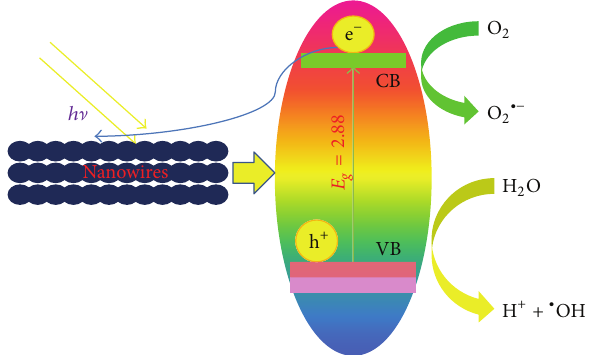
Scheme 1: Electronic structure of NS-TiO 2